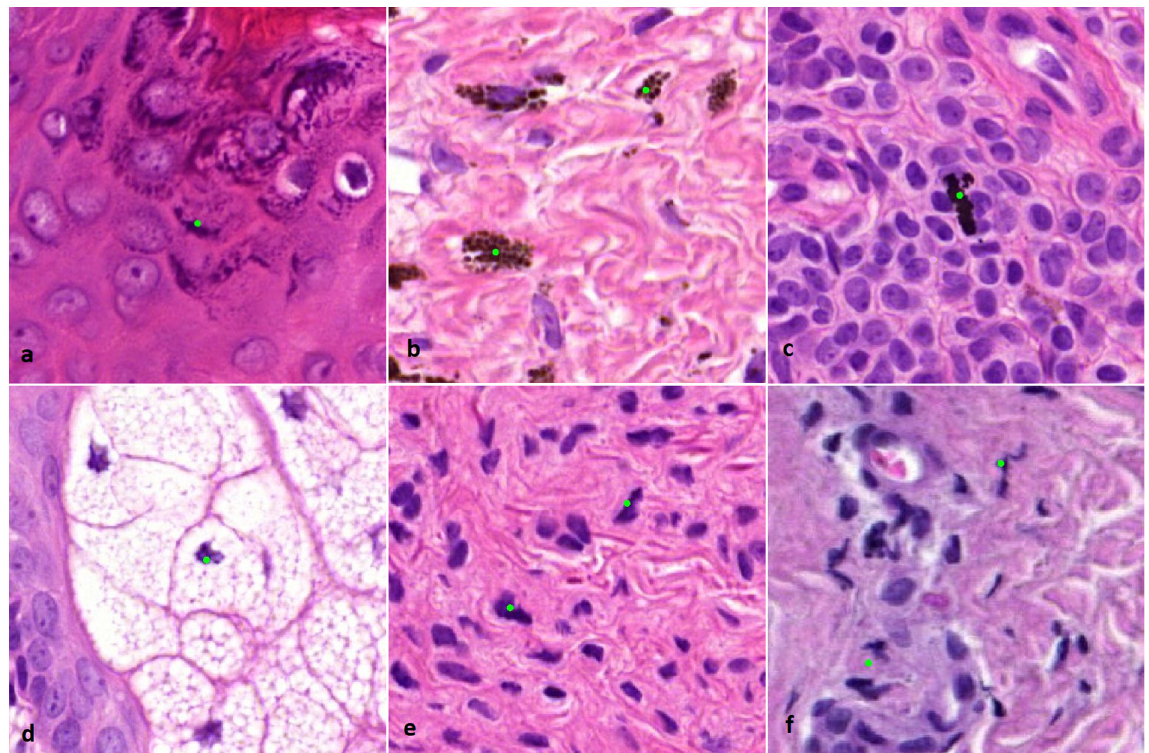
Figure 2. (×800 magnification). Examples of incorrectly indicated mitoses by the algorithm. ( a ) Ker- atin granules. ( b ) Melanin pigment. ( c ) Formalin pigment. ( d ) Nucleus of a sebaceous cell. ( e ) Spindle cell nucleus of a melanocyte. ( f ) Squeezed nucleus of a lymphocyte.